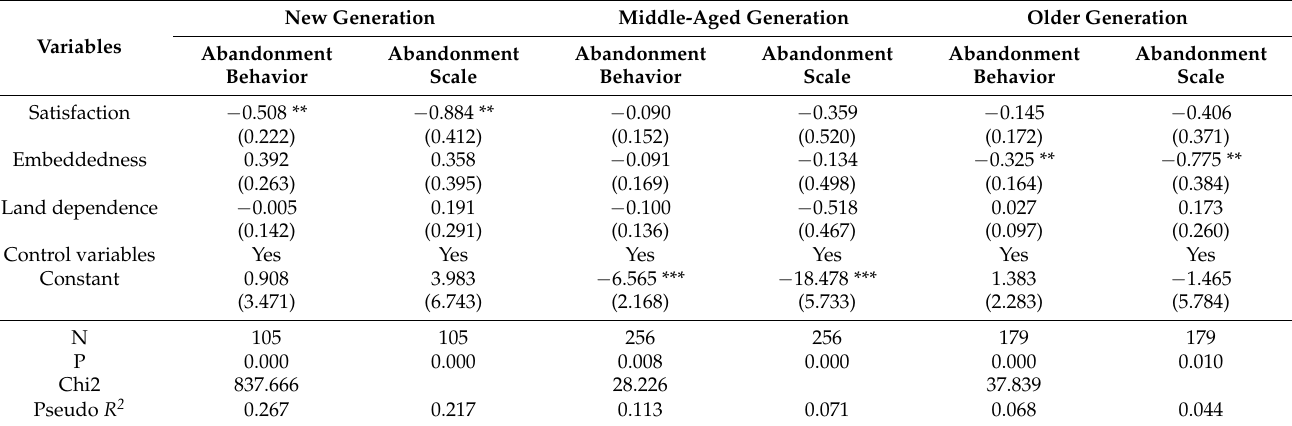
Table 4. Intergenerational differences in the influence of land attachment on land